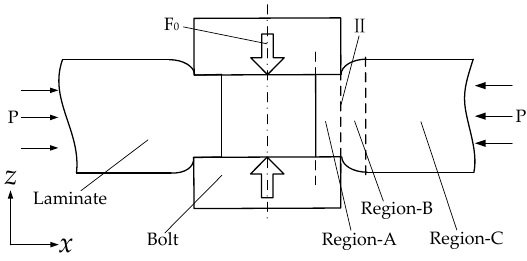
Figure 12. Deformation of filled-hole compression (FHC) testing of composite laminates.